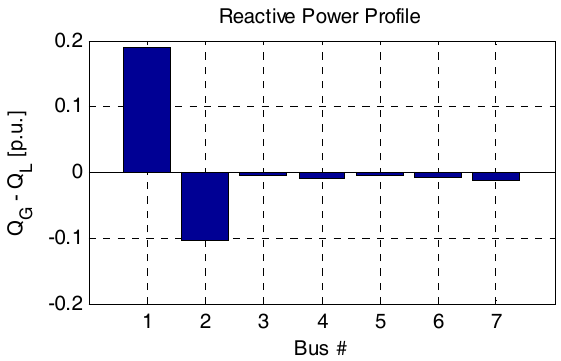
Figure 8. Reactive power in each bus of the 60-kV electrical grid in the Tiaret region.